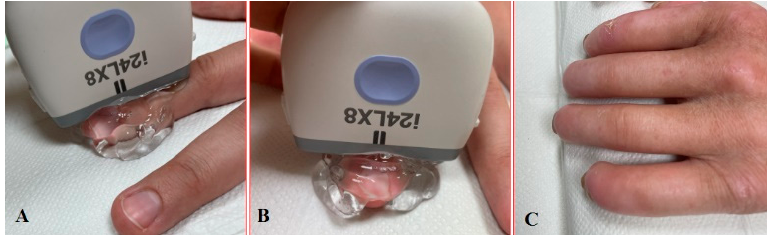
Figure 3. Longitudinal ( A ) and sagittal ( B ) positions during the US investigation. ( C ) Comfortable position for patients with sclerodactyly allows us to make high-quality images and avoid artefacts.